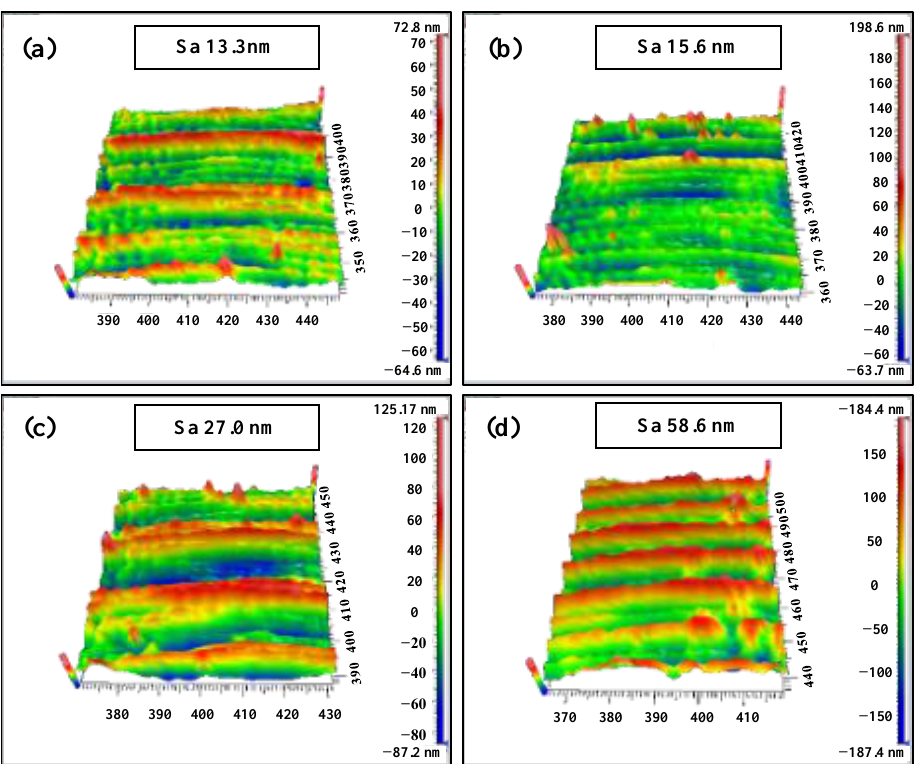
Figure 11. (Scratched surface) Three-dimensional morphological characteristics of experimentally processed microgroove with different feed rates per tooth: ( a ) f t = 0.27 µm/z, f t / r e = 0.15; ( b ) f t = 0.46 µm/z, f t / r e = 0.25; ( c ) f t = 1.37 µm/z, f t / r e = 0.75; ( d ) f t = 5.46 µm/z, f t / r e = 3.0.